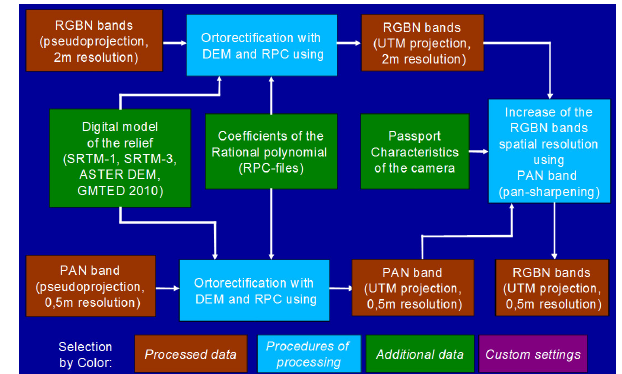
Figure 3. The main stages of preliminary processing of